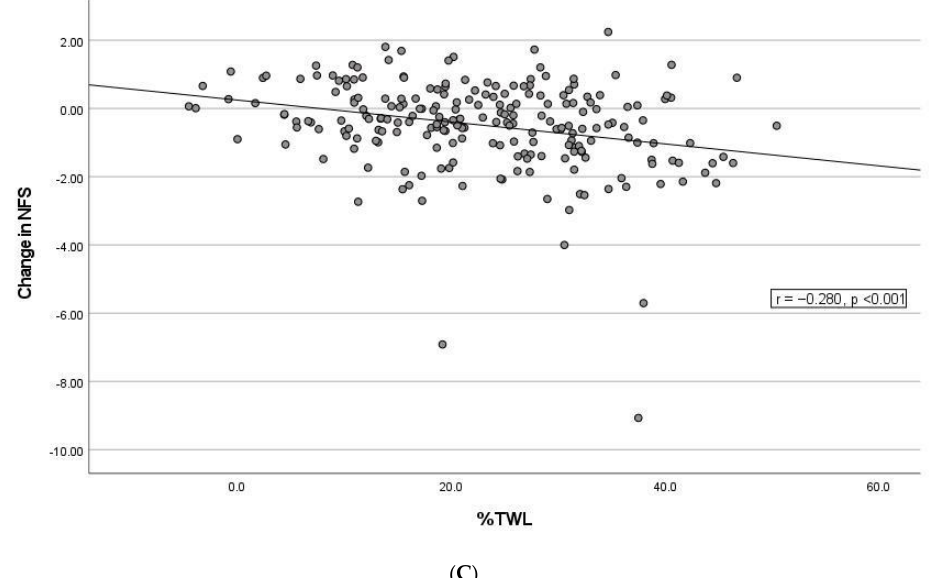
Figure 3. Scatterplots illustrating the correlations between change in NAFLD Fibrosis Score (NFS) and FIB-4 index ( A ) and between %total weight loss and FIB-4 ( B ) and NFS ( C ) following Roux-en-Y gastric bypass surgery. FIB-4, Fibrosis-4 index; NFS, non-alcoholic fatty liver disease fibrosis score; %TWL, percentage total weight loss.